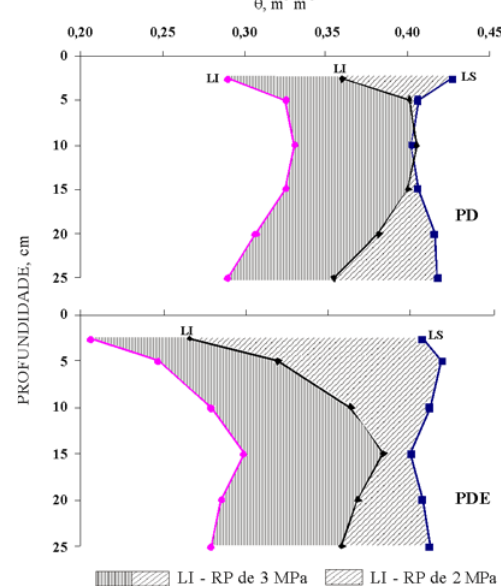
Figura 3. Variação do IHO em